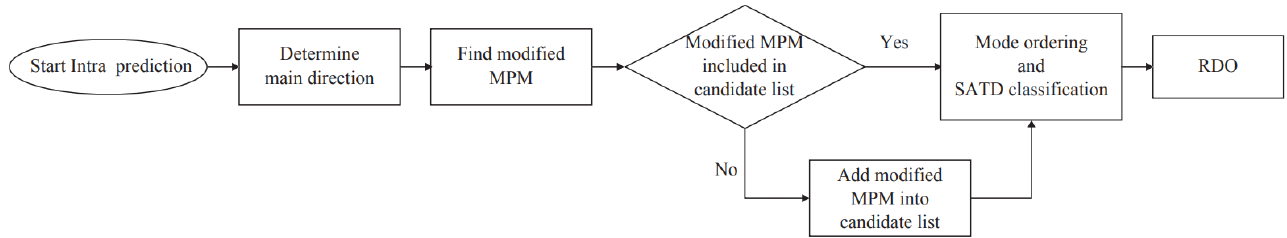
Figure 8. Algorithm for building the mode candidate